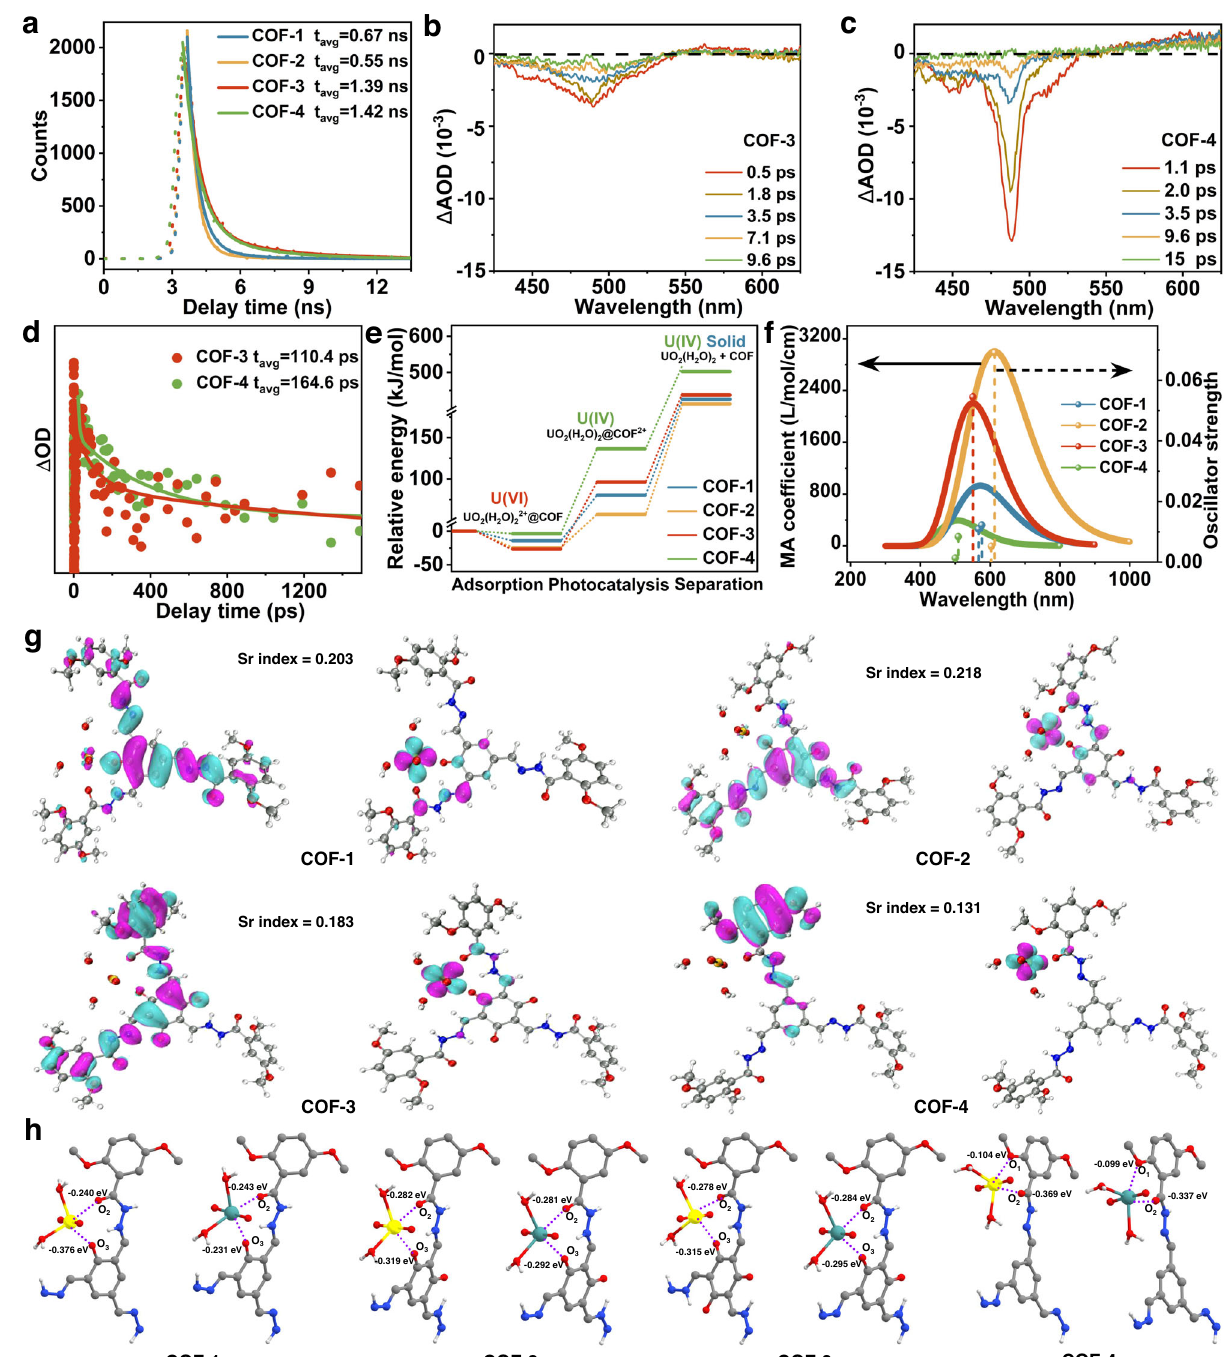
Fig. 5 | Interpretation of photocatalytic mechanisms. a PL lifetime of COF photocatalysts. b , c Time slices of the transient absorption spectra for COF-3 and COF-4, respectively. d Femtosecond time-resolved transient absorption decay kinetics of COF photocatalysts. e The relative free energy diagrams of uranium adsorption and reduction on COF photocatalysts. f The S 1 excited state oscillator